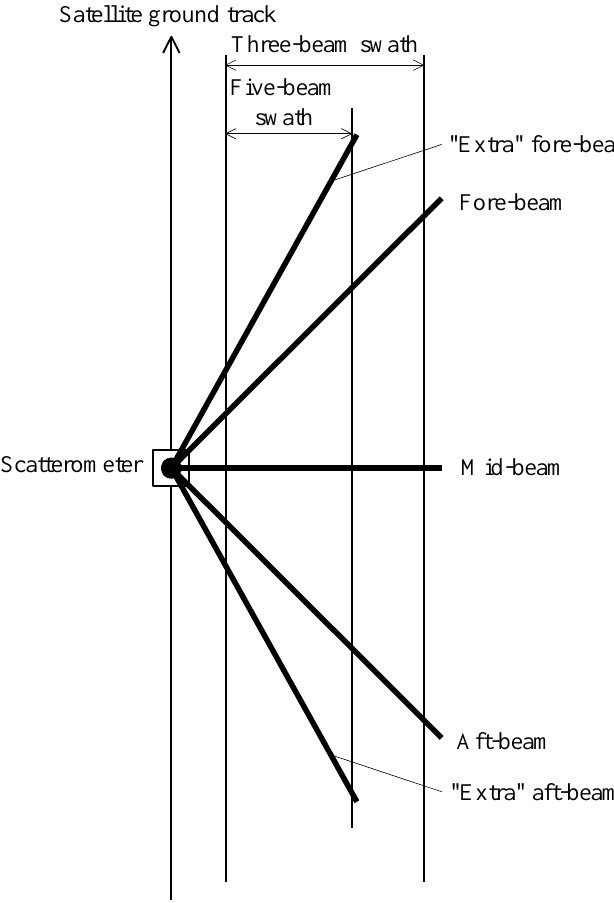
Figure 3. Horizontal projections of the classical three-beam and hypothetical five-beam right-hand scatterometer geometry.